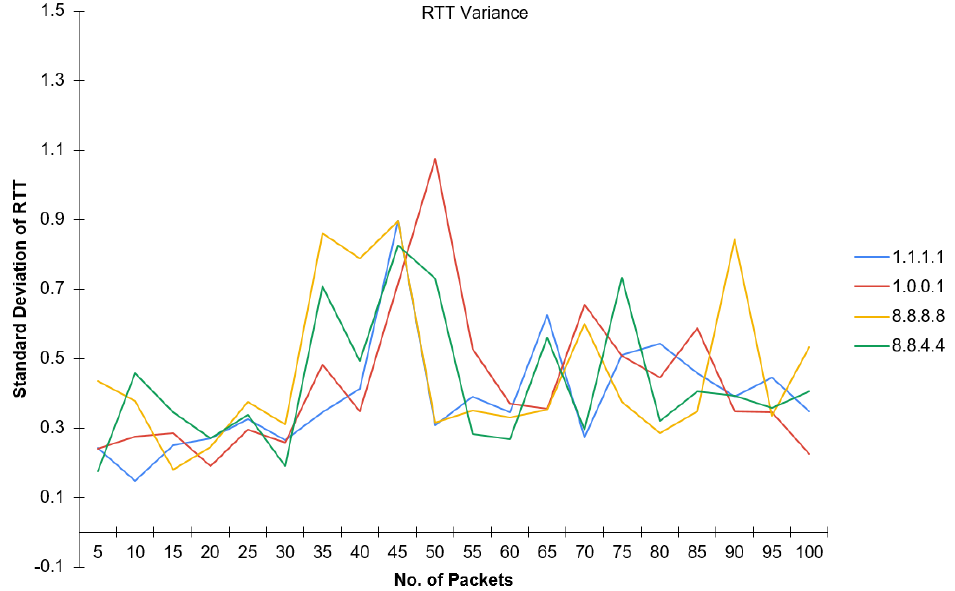
Figure 15. RTT Variance of PING results with remote DNS